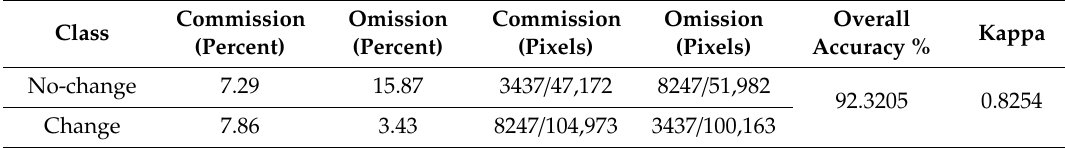
Figure 13. Predicted change image by four trained models. Table 1. Evaluation parameters for